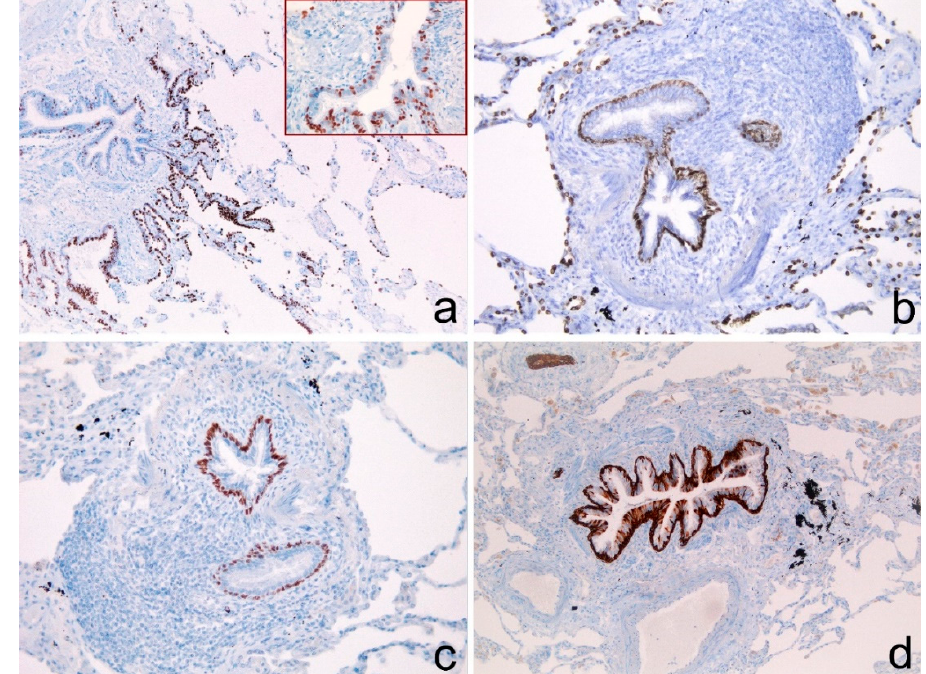
Figure 4. ( a , b ) Basal reserve cells of the terminal bronchioles positive for TTF-1. The insert shows TTF1-positive basal cells at higher magnification. Note TTF1-positive immunostaining also for the pneumocytes II (insert). Serial sections stained for ( c ) p63 and ( d ) CK5/6 showed positive immunostaining in basal reserve cells of TRU. ( a – d ) Immunoperoxidase stain. Original magnification: ( a – d ) 100×; ( b ) 200×; insert: 400×.